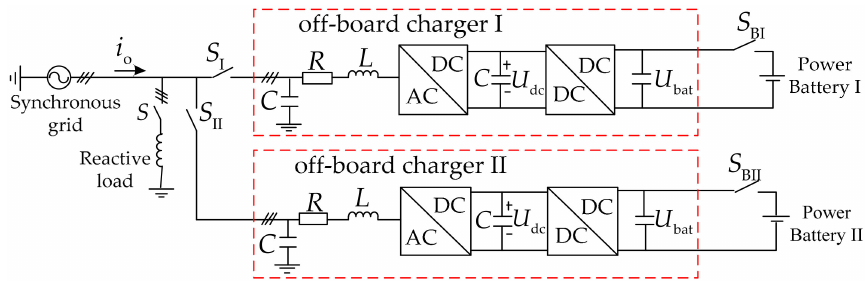
Figure 7. Simulation model structure